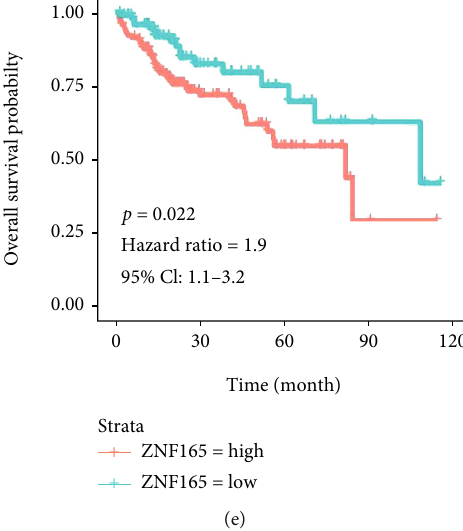
Figure 2: Expression of ZNF165 in liver cancer tissues. (a) The protein levels and distribution of ZNF165 in liver cancer tissues and liver normal tissues were detected by immunohistochemical (IHC) staining. (b) The protein levels of ZNF165 in liver cancer tissues and liver normal tissues were evaluated by immunoblotting. (c) Cases in TCGA and ICGC were divided into the high- and low-ZNF165 expression related to immune cell in fi ltration. (d) The mRNA expression of ZNF165 in liver cancer tissues and liver normal tissues was analyzed based on TCGA database. (e) Correlation between ZNF165 expression and the overall survival in liver cancer patients. Table 1: The univariate and multivariate Cox